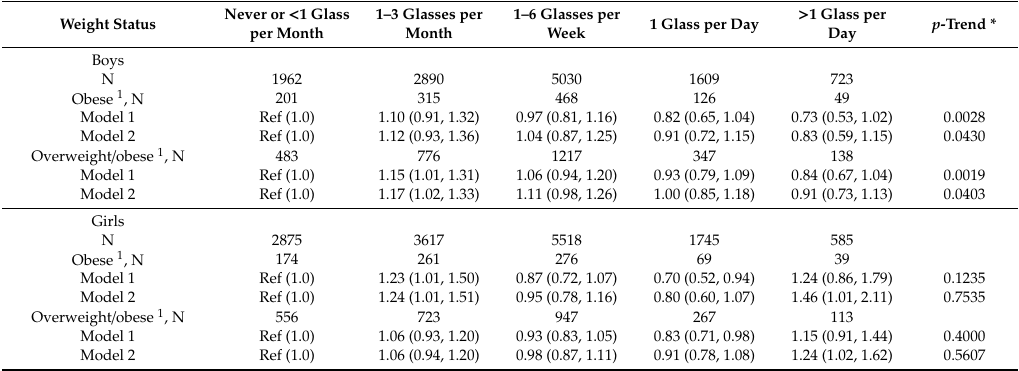
Table 4. Adjusted odds ratios for obesity and overweight of GUTS I and II participants by level of 100% OJ consumption (OR and 95%